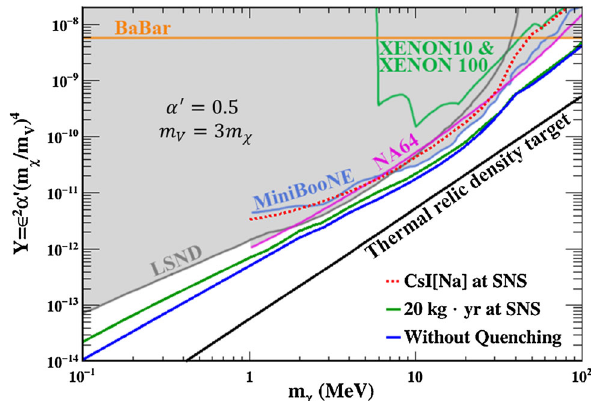
Fig. 17 Predicated90%sensitivitytolow-massdarkmatterproduction parameters in case of the vector portal theory assuming α (cid:7) = 0 . 5 and